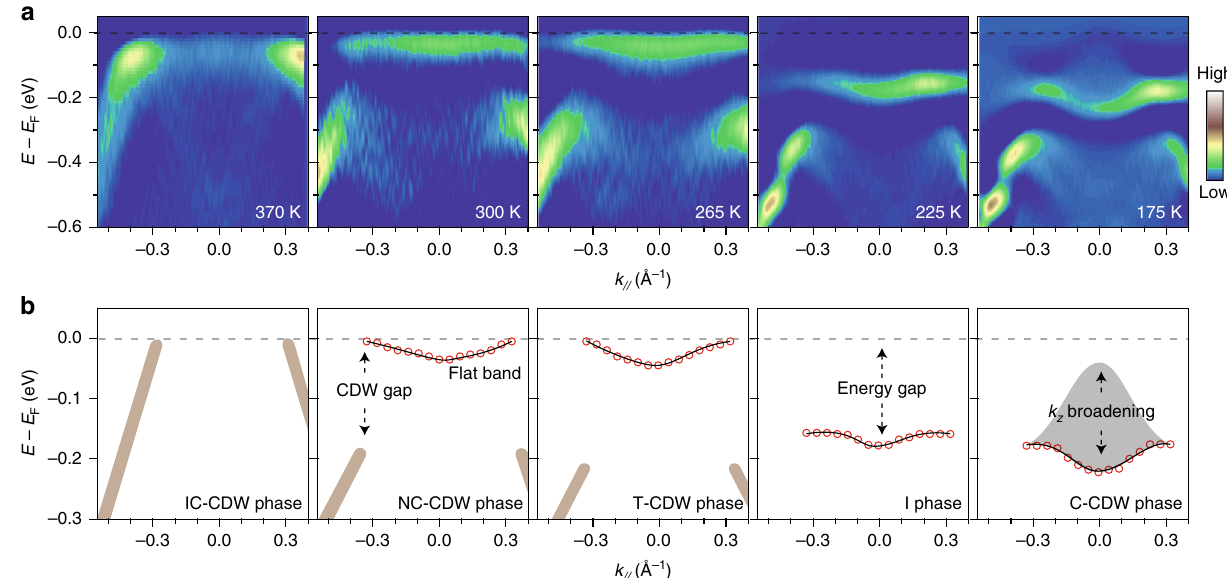
Fig. 3 Evolution of the fl at band crossing different electronic phases. a The second derivative images of the energy – momentum cuts taken along the Γ – M direction in different electronic phases. b The schematic illustration of band evolution crossing different phases. Red circles show the fi tted peak maxima from the data in a . Black lines guides the eyes to the fl at band dispersions. Brown thick lines illustrate the bands at high binding I and C-CDW phases. The results are compared in Fig. 4. The fl at band is gapped at 225 K. The weak photon energy dependence indicates the two dimensionality of the fl at band in the I phase. However, when entering the C-CDW phase, the data become strongly photon energy dependent. The band positions shift from − 230 to − 90 meV periodically. This shows that the bandwidth along the k z direction is around 140 meV in the C-CDW phase, Fig. 3. The photon energy-dependent data con fi rm that the k z band dispersion reconstructs strongly at the I to C-CDW phase transition. More intriguingly, the periodicity of the k z dispersion is around 2 π /2 c in the C-CDW phase, which indicates the existence of an interlayer dimerization.